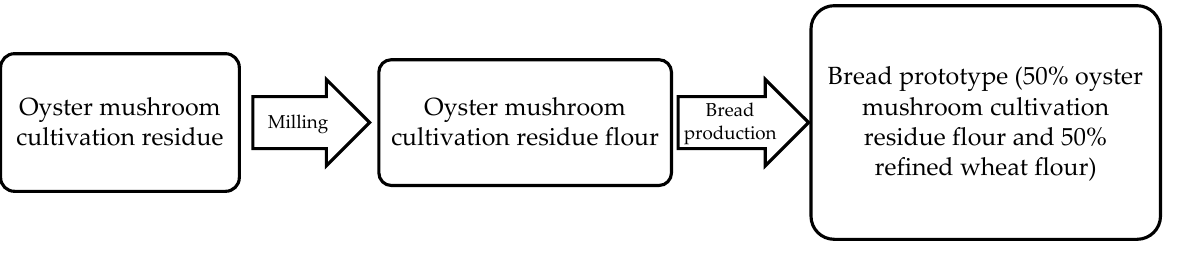
Figure 1. Bread prototype development.